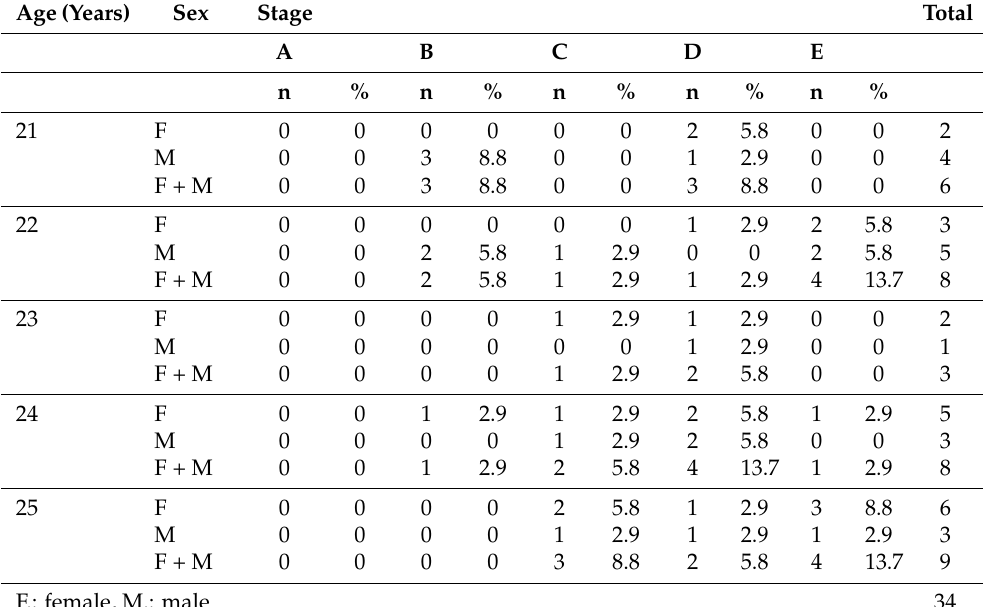
Table 4. Distribution of the MPS maturational stages by age and sex in group of 21- to 25-year-olds. Age